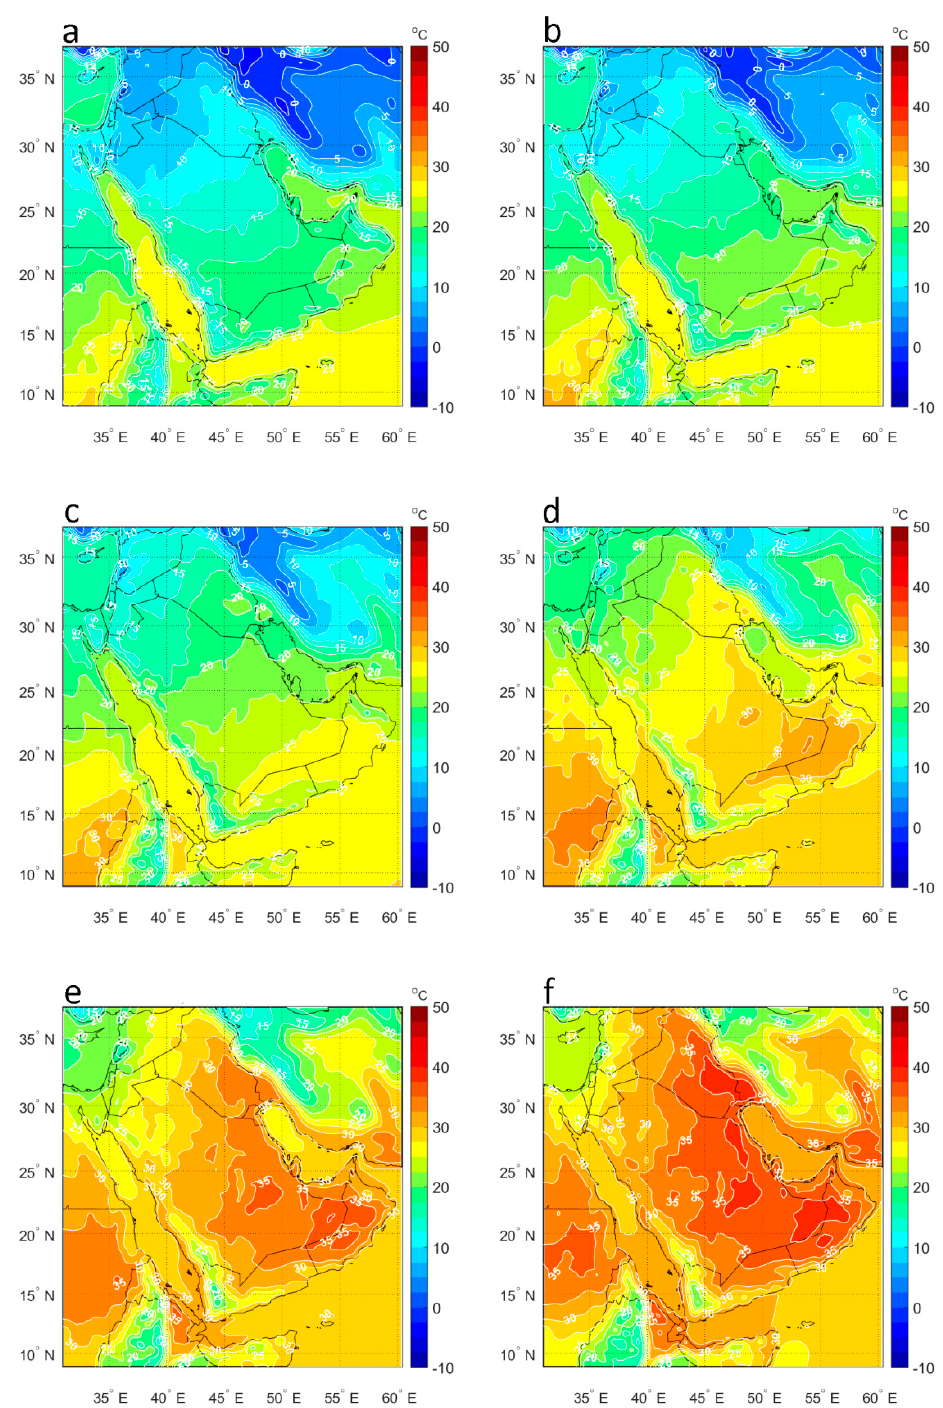
Figure A1. Mean 2 m Temperature for the months January to June ( a – f ).